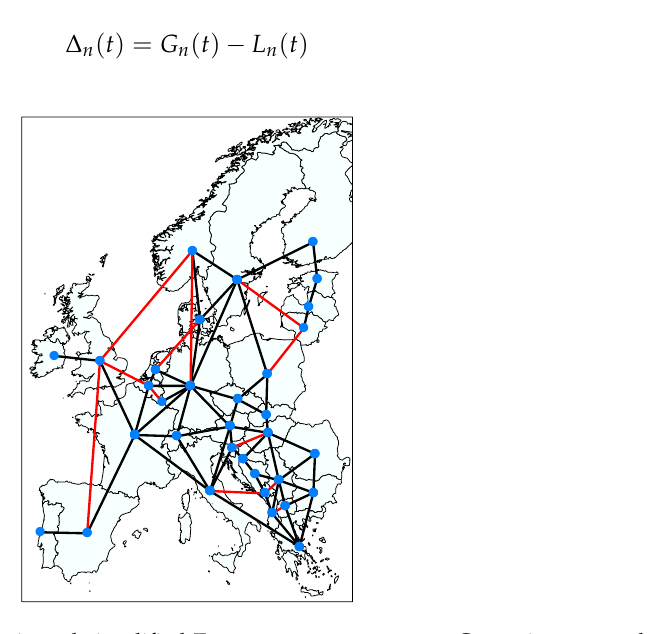
Figure 1. Topology of the investigated simplified European power system. Countries are modeled as nodes and connected by inter-country transmission links. Black links are existing connections, and red ones are either planned or under